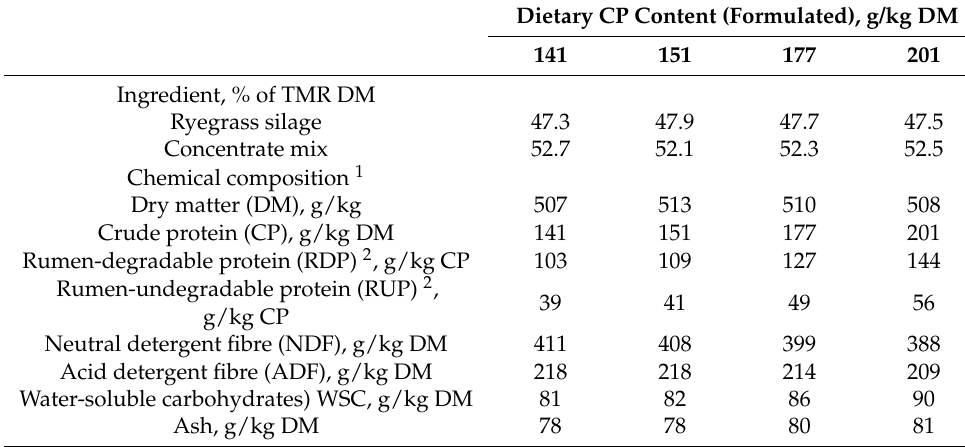
Table 1. Composition of the TMR treatment